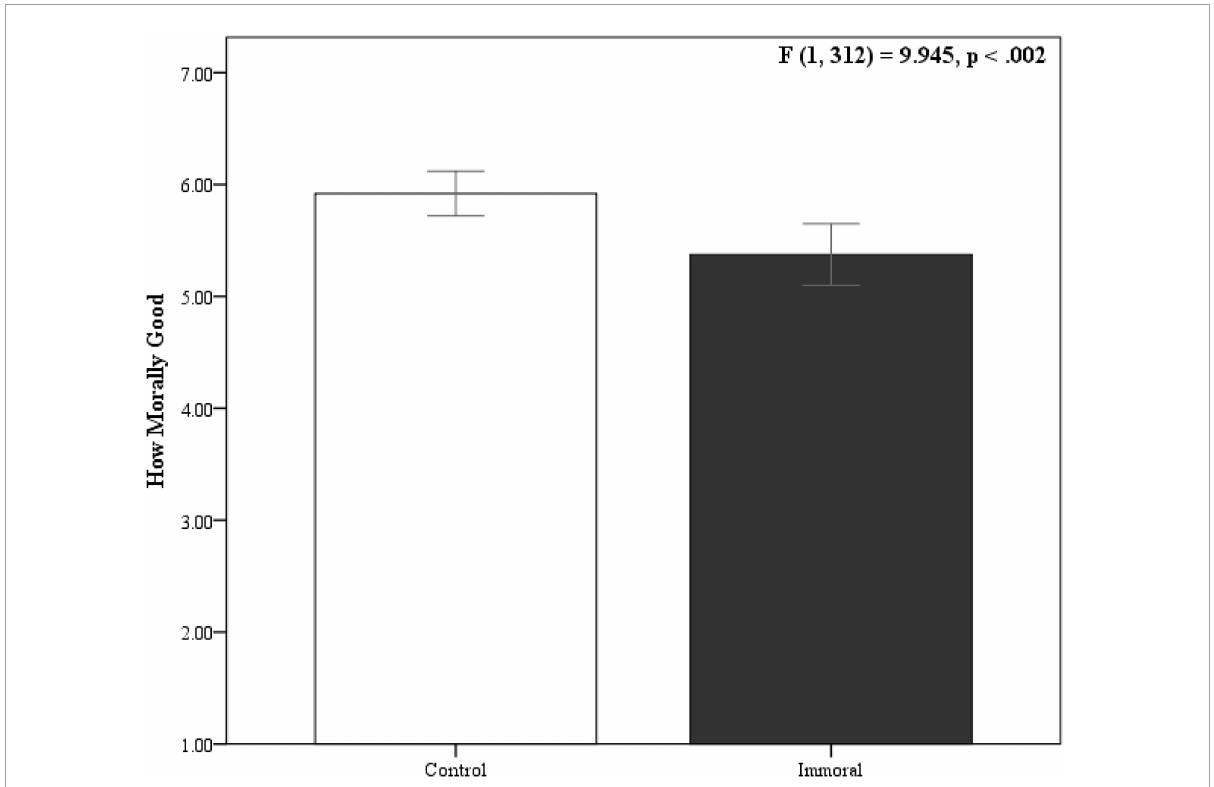
FIGURE2 Moral contamination with ulterior motives. Error bars represent 95%